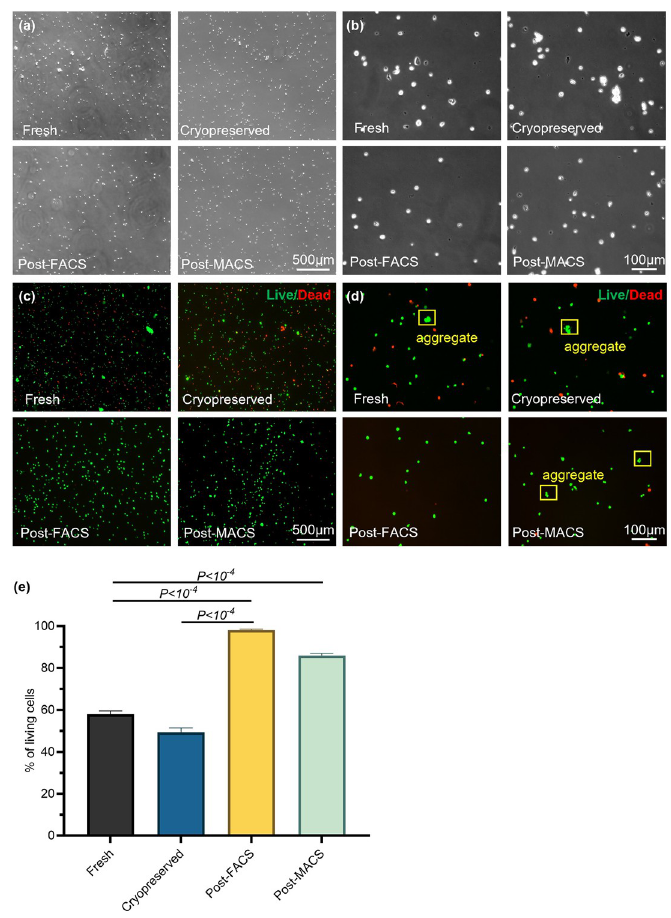
Fig 1. Efficient single cell preparation. Phase (a, b), live/dead staining (c, d), and flow cytometry viability quantification (e) of fresh isolated, cryopreserved, post-FACS, and post-MACS pig skin cells. n = 3 for (e).